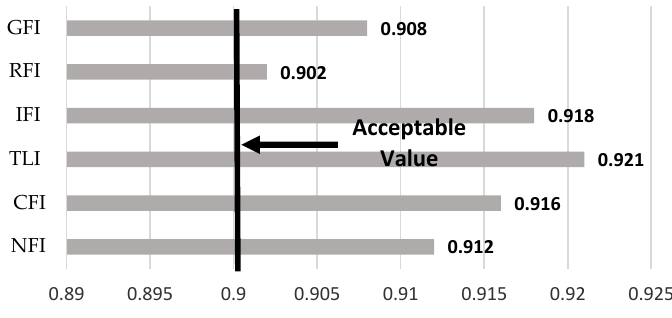
Figure 8. Model fit analysis.